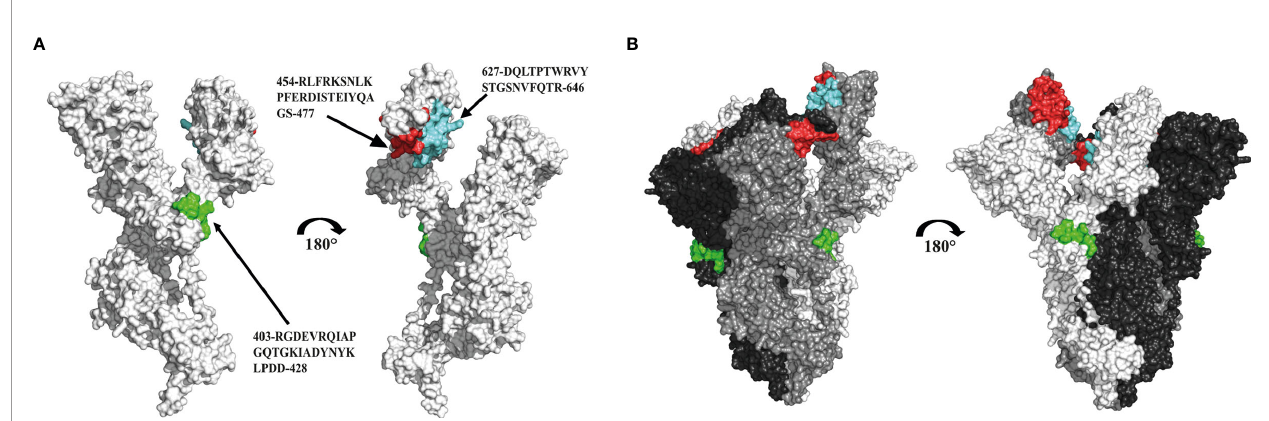
FIGURE 3 | Immunogenic peptides used in a peptide vaccine against SARS-CoV-2. (A) Structural representation of a SARS-CoV-2 S glycoprotein monomer in closed state (PDB: 7DK3), showing the location of the epitopes and sequences used for the design of a peptide vaccine against SARS-CoV-2 (cyan, red and green). (B) Structural representation of the trimer formed by three protomers of the S glycoprotein (white, grey and black), and location of the antigenic epitopes in the oligomeric